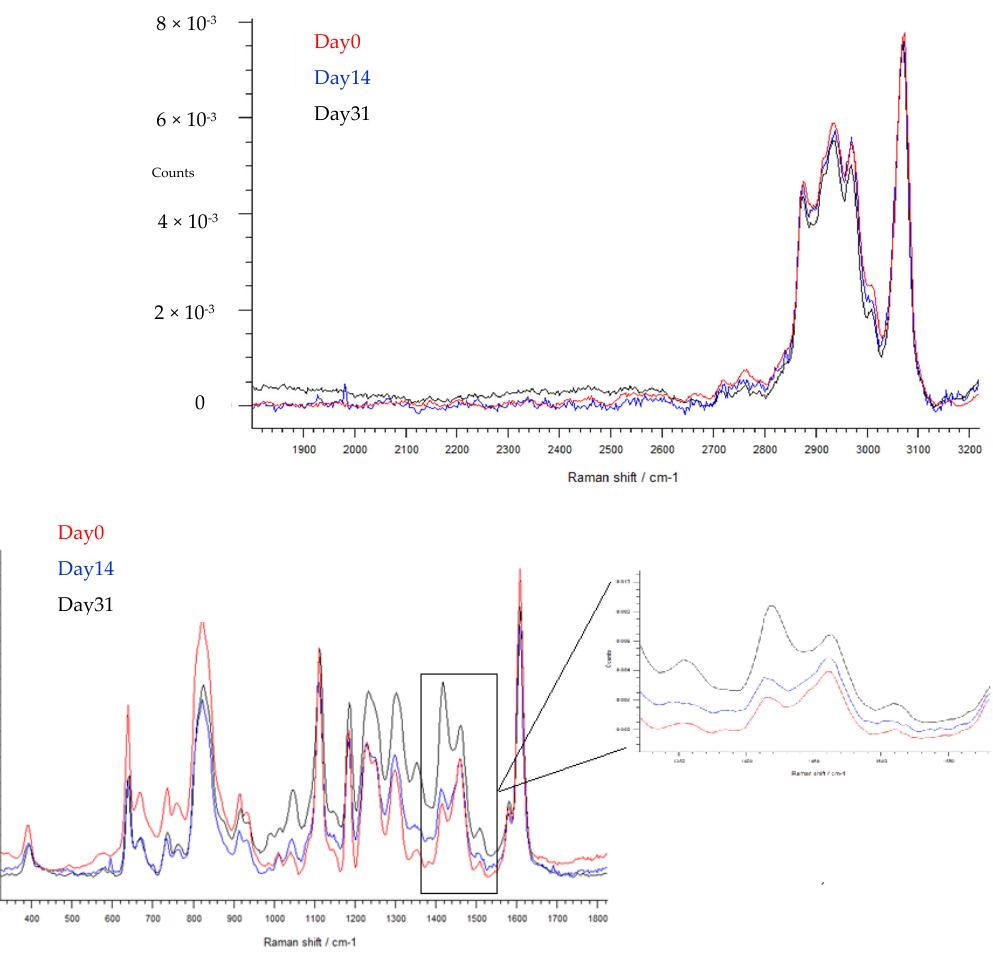
Figure 14. Comparison of the Raman Spectrum of the resin at different aging times for the area between 1800–3200 cm −1 (top) and between 300–1800 cm −1 (bottom) .